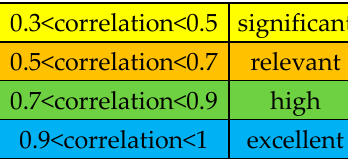
Table 2. Empirical rules adopted in the evaluation of correlations. Colors indicate the “goodness” of correlation: yellow = significant; orange = relevant; green = high; blue = excellent.